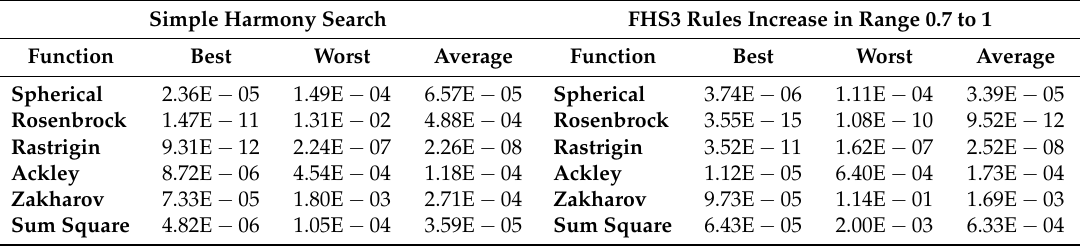
Table 11. Comparison results obtained with FHS3 and the harmony search